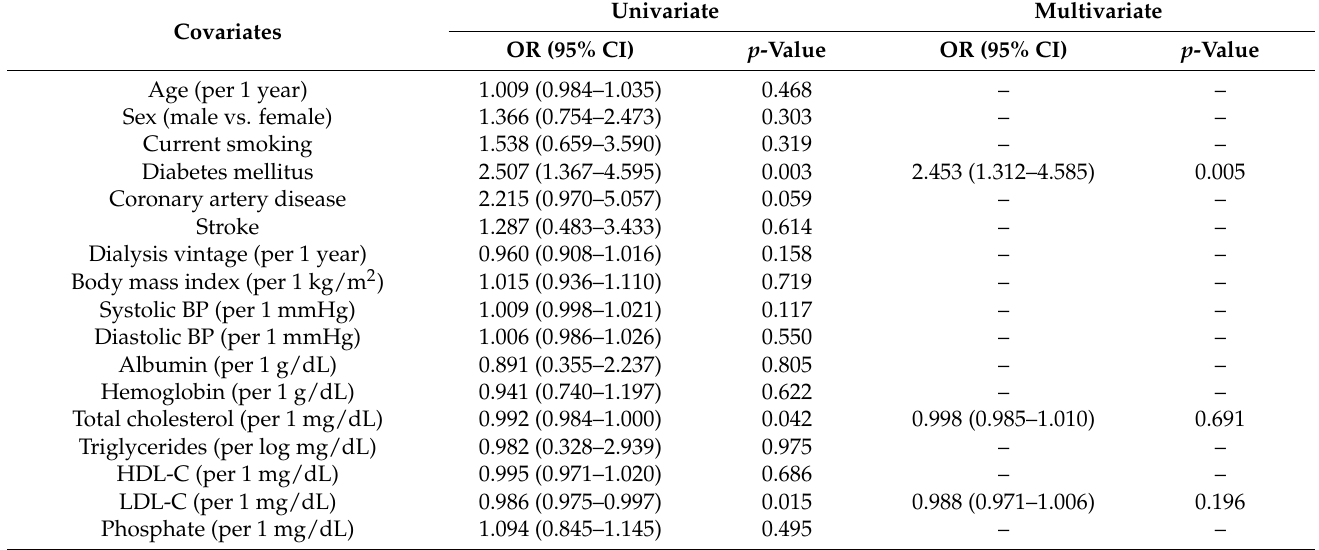
Table 4. Determinant factors of LAVI > 34 mL/m 2 using univariate and multivariate logistic regression.